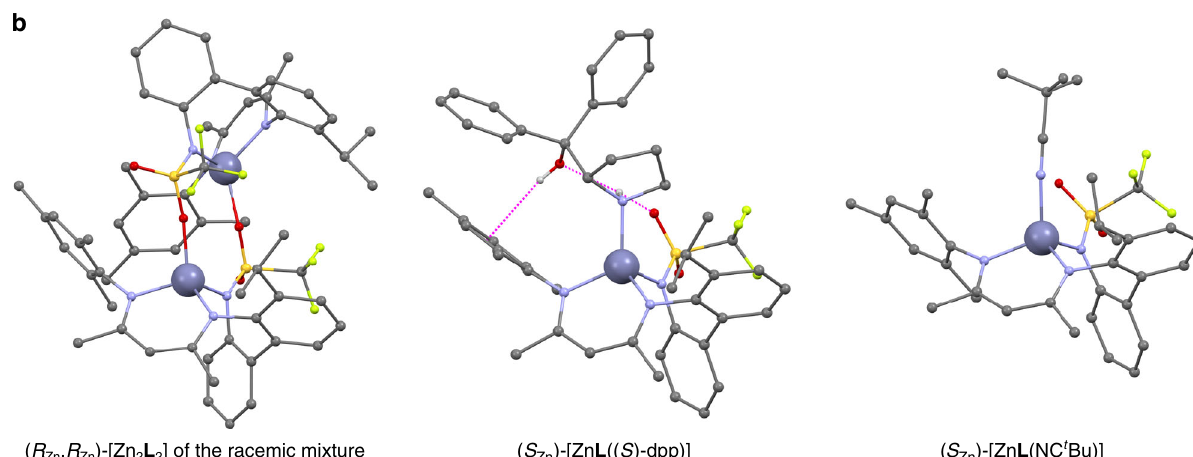
Fig. 3 Synthesis of enantiopure ( S Zn )-[ZnL(NC t Bu)] by highly diastereoselective asymmetric induction using a coordinating chiral auxiliary followed by replacement with an achiral t BuCN molecule. a Reaction scheme. RT room temperature, HMDSO hexamethyldisiloxane, equiv. equivalents, ee enantiomer excess. b X-ray single-crystal structures of three zinc complexes in a ball-and-stick model. Hydrogen atoms on carbon atoms and solvent molecules are omitted for clarity. For ( S Zn )-[Zn L (( S )-dpp)], one of the crystallographically independent but structurally similar molecules is shown. Colour code: Zn, blue grey; C, grey; N, blue; O, red; F, yellow green; S, yellow. Dashed magenta lines denote plausible hydrogen